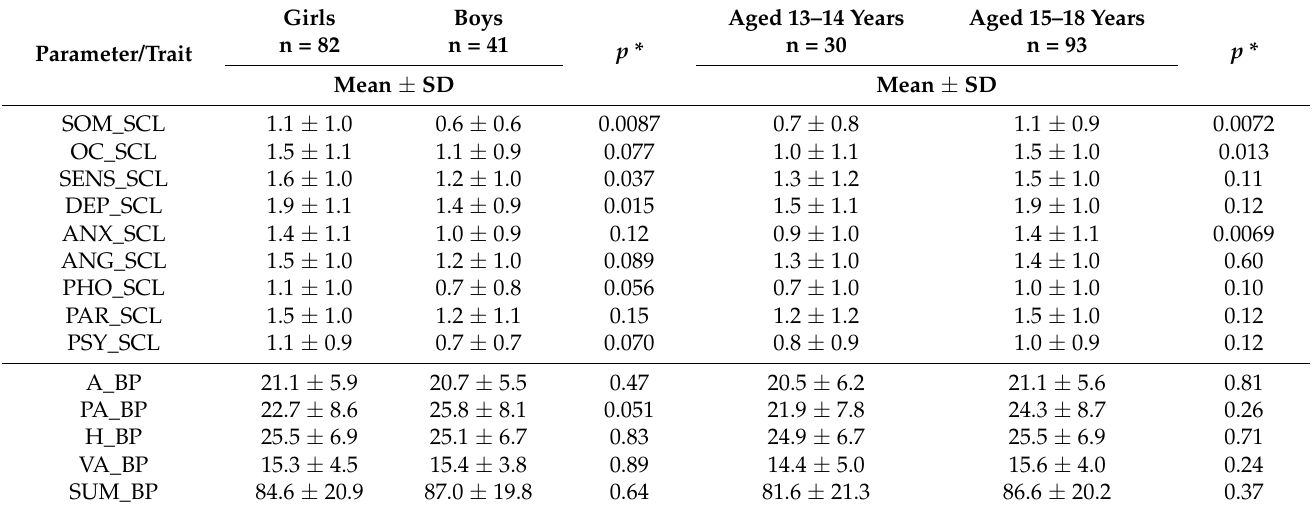
Table 1. Comparative analysis of psychological characteristics of adolescents, depending on gender and